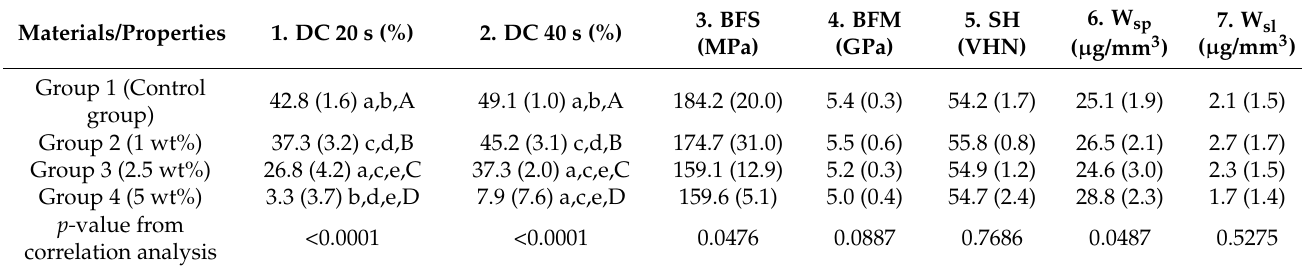
Figure 3. Representative FTIR spectra of composites before and after curing for 20 and 40 s from each group. Table 2. The results (mean and SD) from each group. The same lowercase letters indicate significant differences ( p < 0.05) between groups in the same column. The same uppercase letters indicate significant differences ( p < 0.05) in DC in the same group after curing for 20 or 40